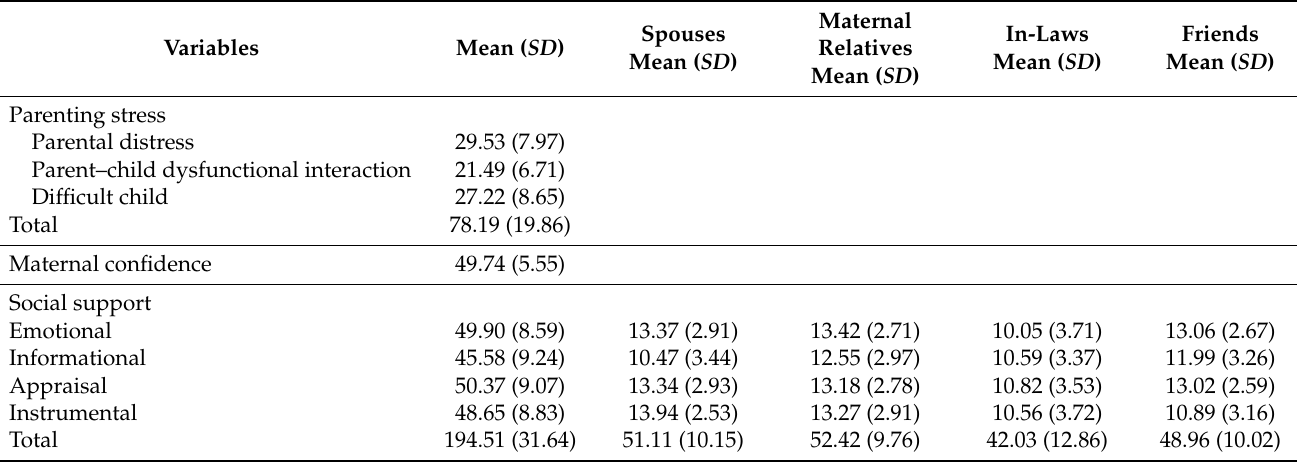
Table 2. Descriptive statistics of social support, parenting stress, and maternal confidence ( N = 205).